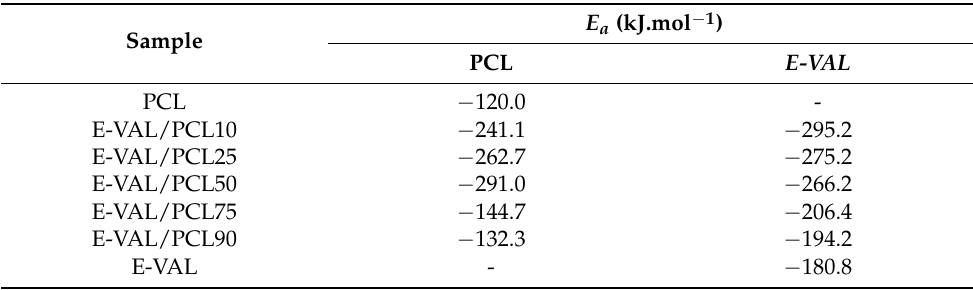
Table 10. Activation energies of the crystallization of pure E-VAL, PCL, PCL in E-VAL/PCL, and E-VAL in